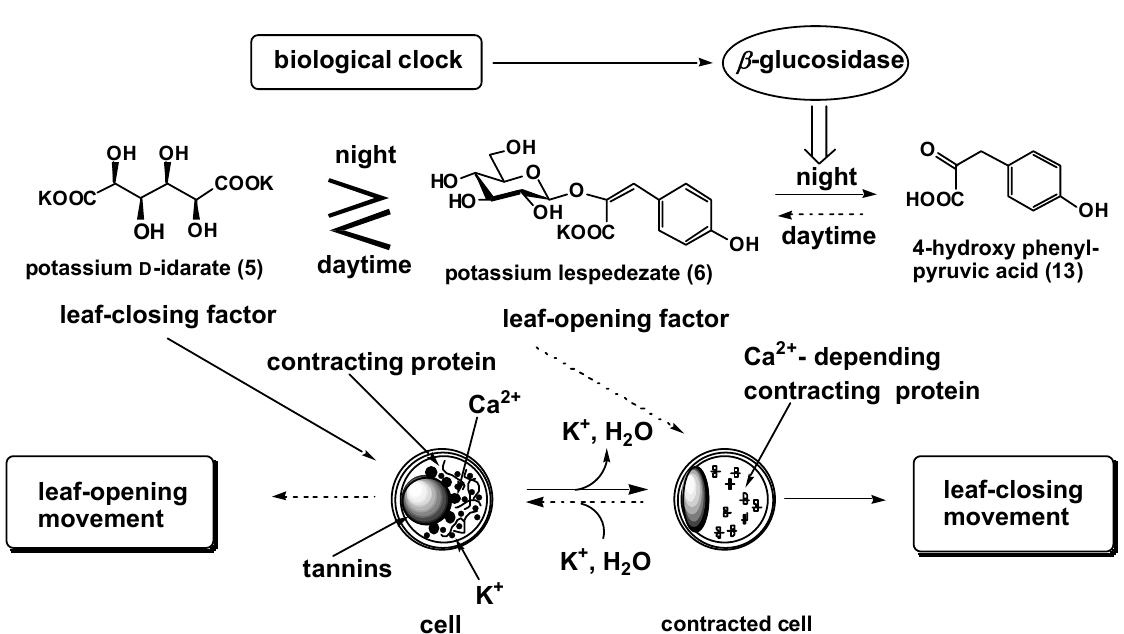
Figure 2. Chemical control of nyctinasty in Lespedeza cuneata G.